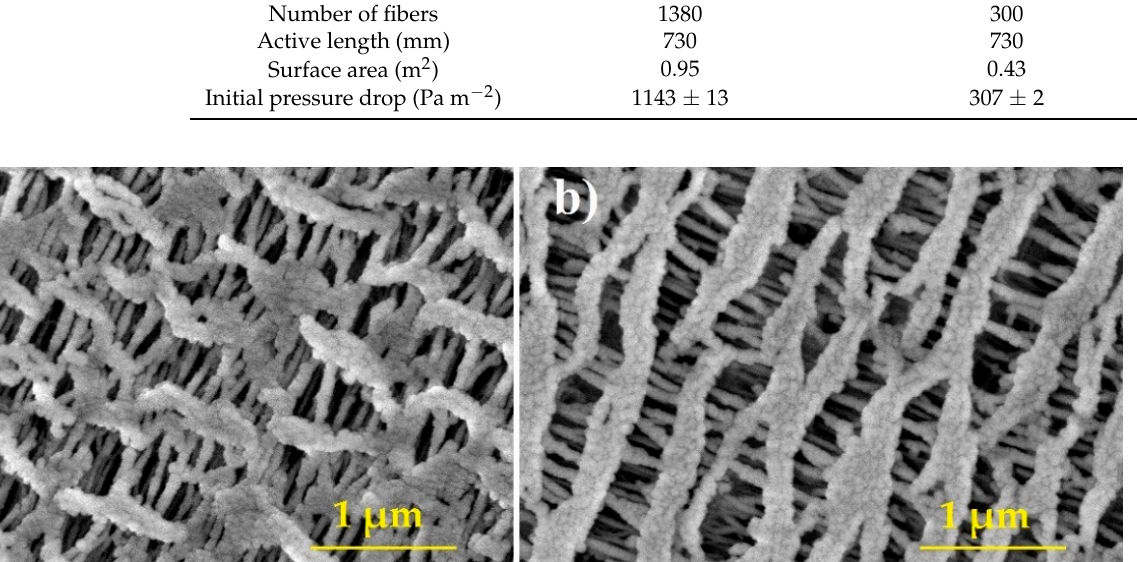
Figure 1. Pore structure of tested hollow ‐ fiber membranes P60 ( a ) P80 ( b ).